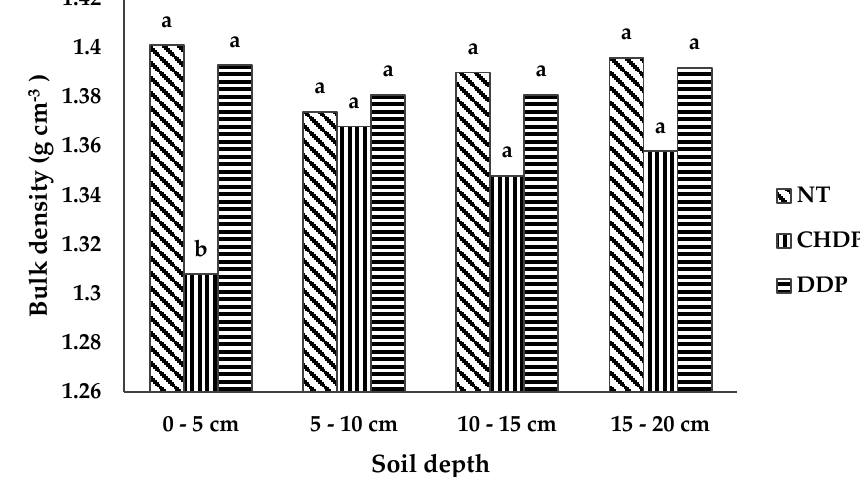
Figure 6. Bulk density in the soil profile at intervals of 5 cm at the beginning of the experiment in 2013. Mean values with the same letter in the same depth interval are not significantly different (Tukey, α ≤ 0.05).